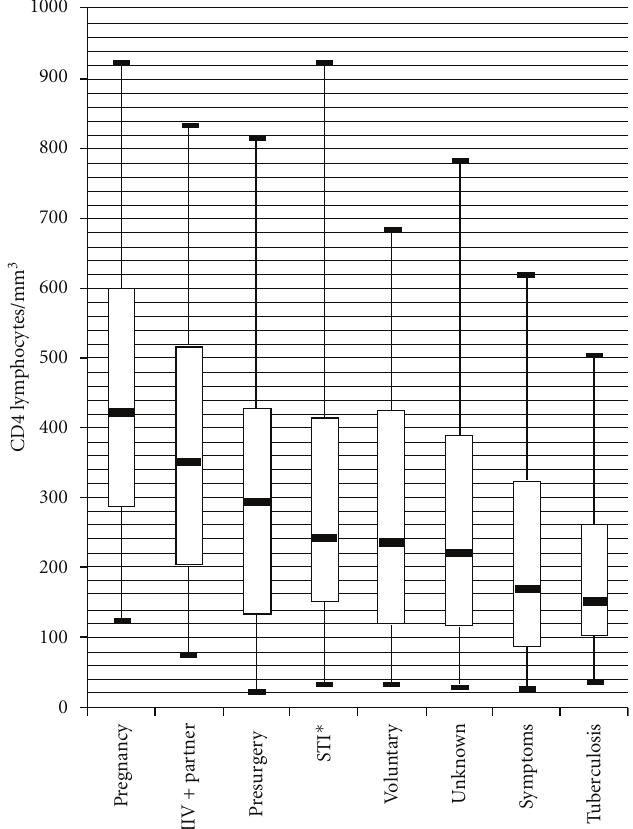
Figure 2: Description of CD4 lymphocyte count by reason for HIV testing in descending order from right to left. Boxes represent median and 25–75 percentiles. Whiskers represent 5 and 95 percentiles. ∗ STI: sexually transmitted infection.